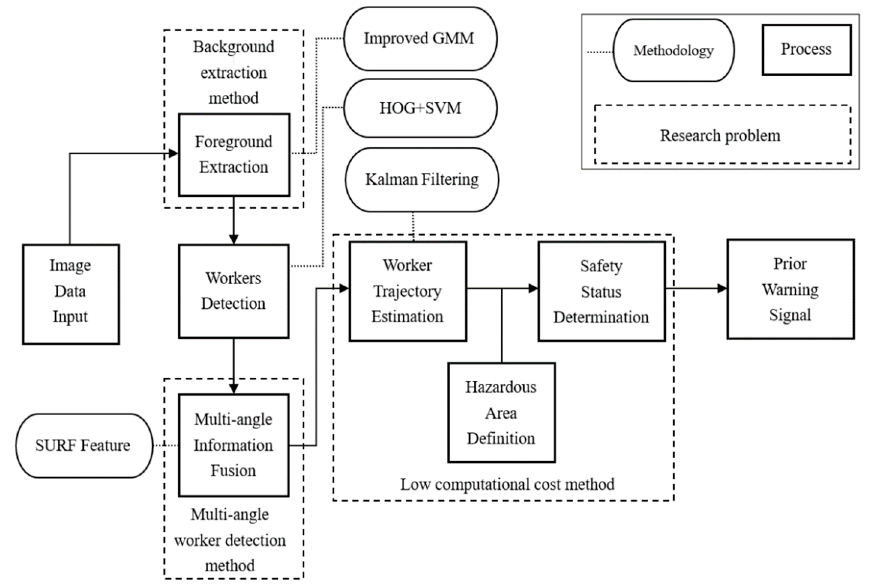
Figure 1. Overview of the framework.